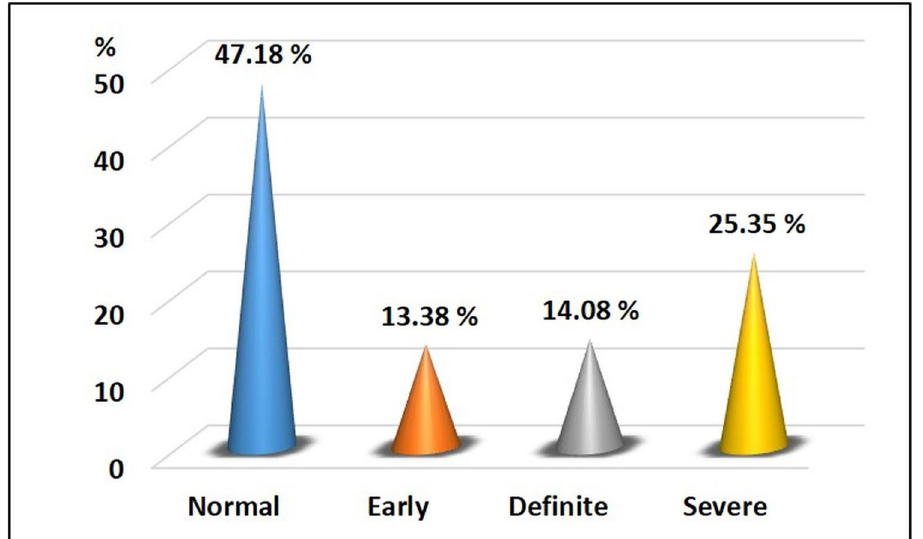
Figure 1. Staging of cardiac autonomic neuropathy in the diabetic patient.